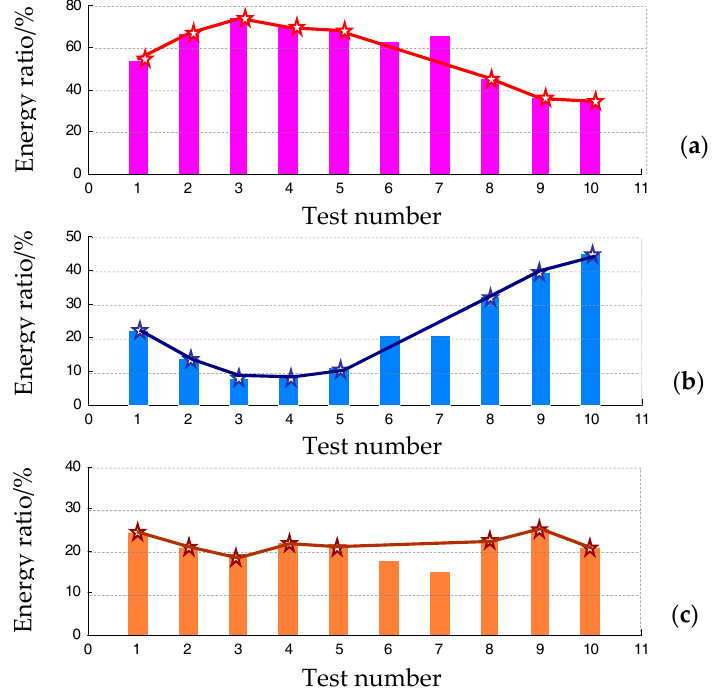
Figure 23. Energy weight of the three harmonic tones of the fundamental working frequency: ( a ) the first order, ( b ) the second order, and ( c ) the third order.